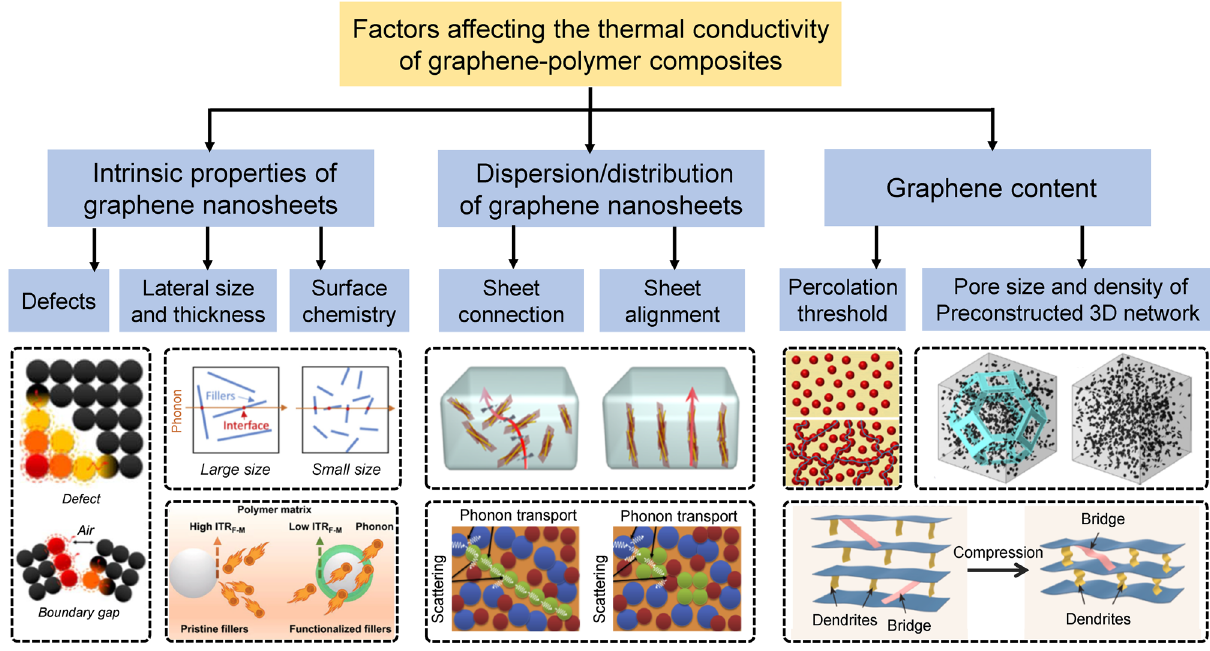
Fig. 1 Factors affecting thermal conductivity of polymer composites functionalized by graphene 3D networks